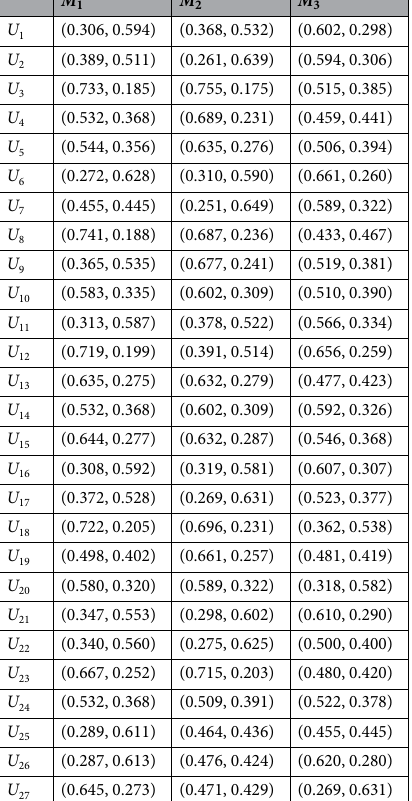
Table 6. The A-IFDM for SIBOs